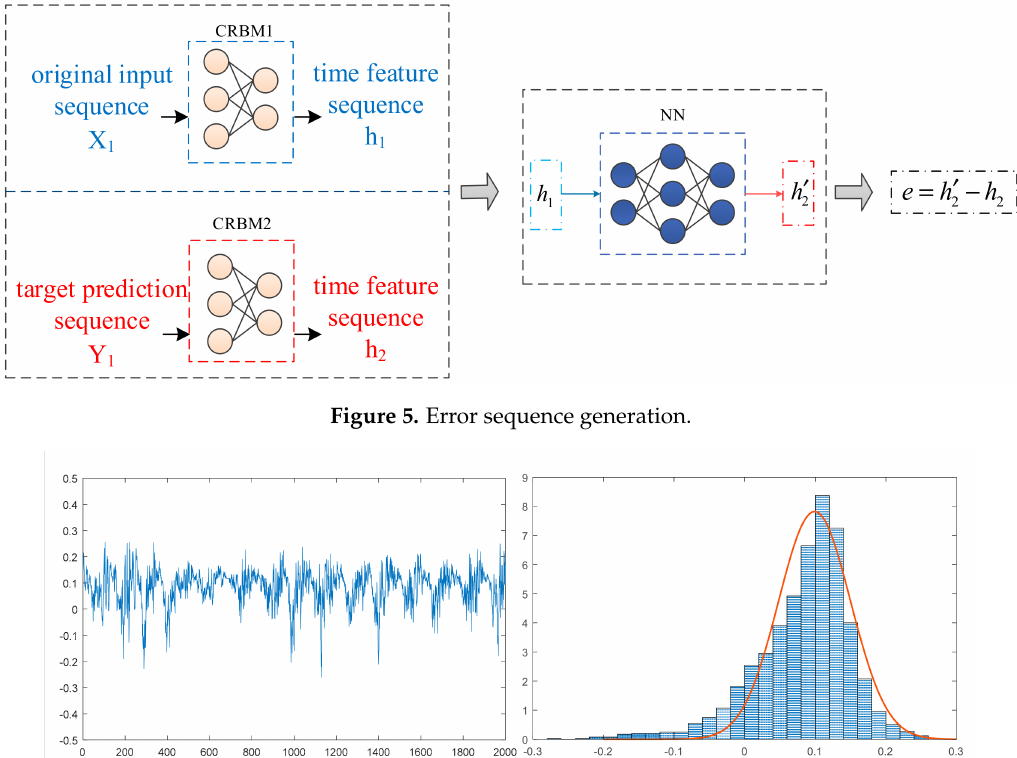
Figure 6. Error sequence and probability density distribution